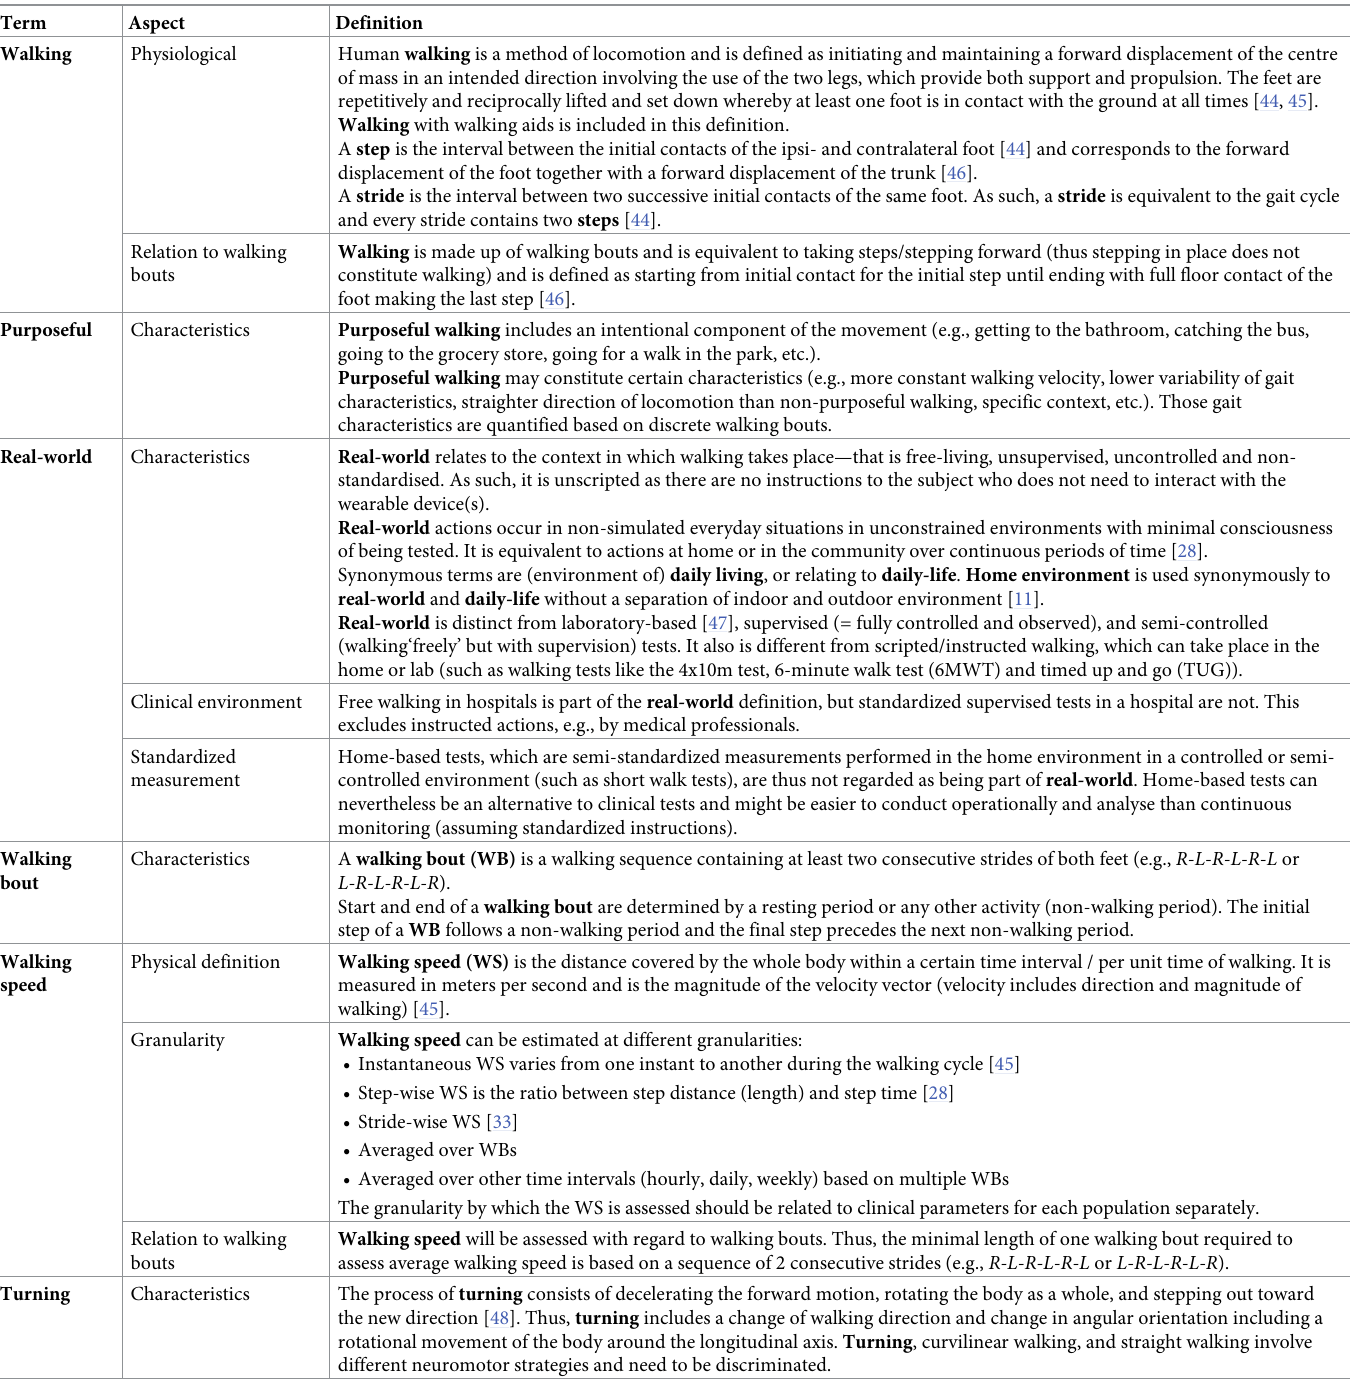
Table 4. Agreed definitions of terms related to real-world walking. Term Aspect Definition Walking Physiological